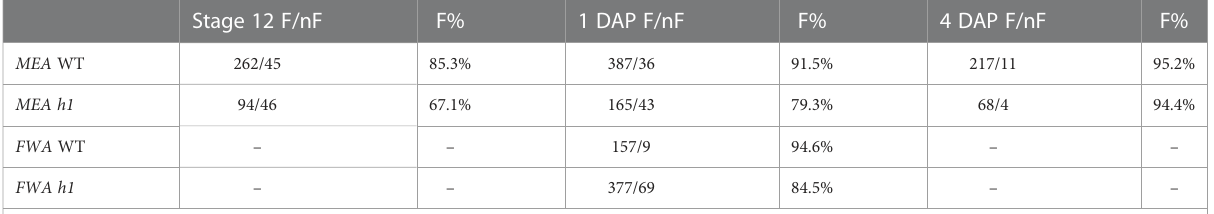
F/nF represents the ratio of fl uorescent and non fl uorescent ovules or seeds. F% represents the percentage of fl uorescent ovules or seeds among total checked ovules or seeds. WT, wild type Col-0; h1 , h1 triple mutant; stage 12, fl ower stage 12; DAP, Days After